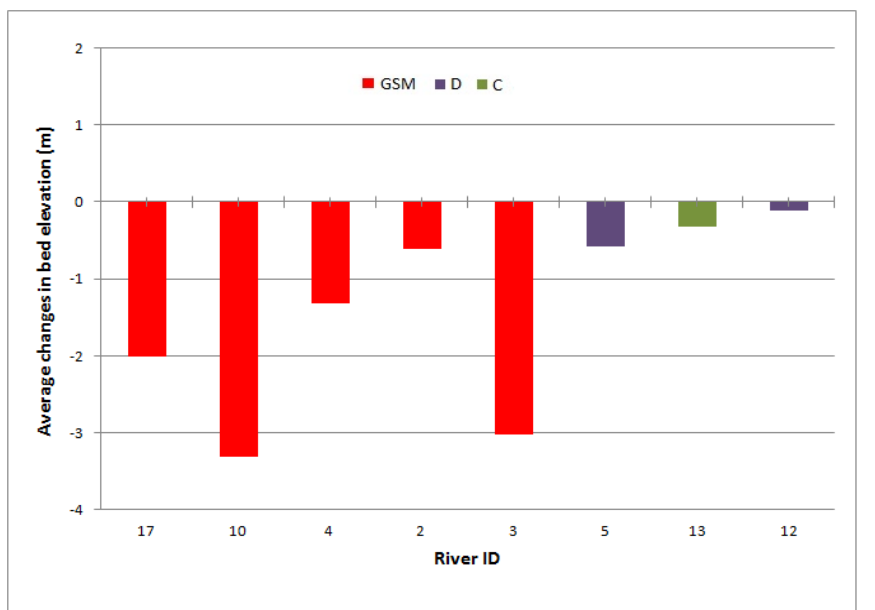
Figure 6. Changes in bed elevation and relative causes in Iranian rivers. GSM: Gravel and sand mining, D: Dam, C: Channelization.